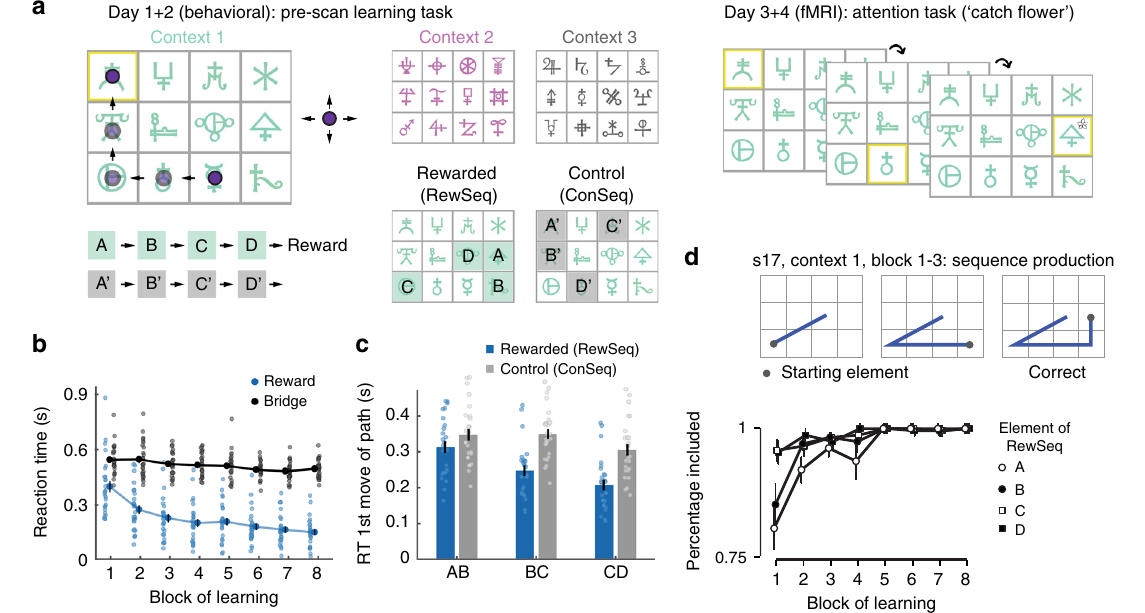
Fig. 1 Learning of reinforced sequences occurs backwards from reward. a Pre-scan learning task (left): on day 1 + 2 of testing, participants moved an agent (purple circle) to highlighted stimuli (yellow) using up/down/left/right buttons. For each of three fi xed 3 × 4 layouts (contexts: green, pink, gray), they had to learn a hidden sequence (ABCD) that led to reward. This reinforced sequence (RewSeq) was embedded in a continuous stream of highlighted stimuli and thus learnt by trial and error, and its beginning and length inferred over time. A control sequence (ConSeq) composed of other stimuli (A ′ B ′ C ′ D ′ ) was encountered equally frequently but not followed by reward. Scan task (right, day 3 + 4): one stimulus was highlighted after another, but now participants had to press a button when they detected a fl ower on the highlighted square. By carefully controlling the order of stimuli, we could probe representations